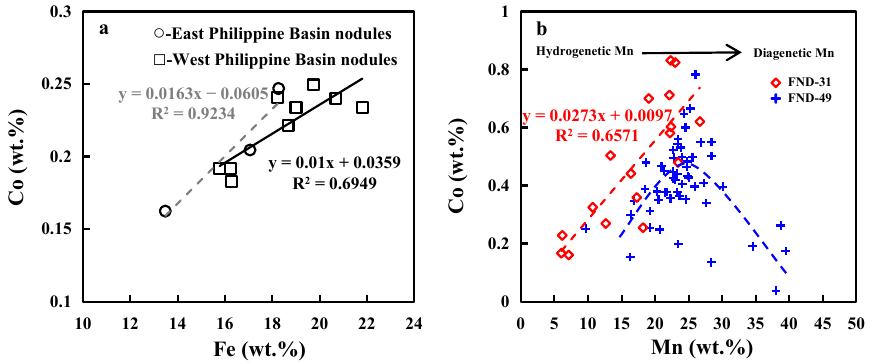
Figure 6. ( a ): Relationship of Fe with Co (from bulk analyses); ( b ): Relationship of Mn with Co (from in situ EMPA analyses).